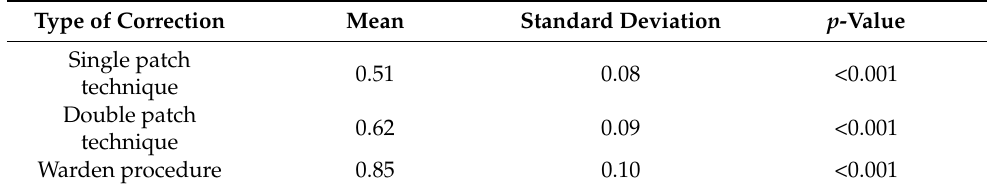
Table 1. Mean PAPVR ratio value according to the surgical procedure performed.